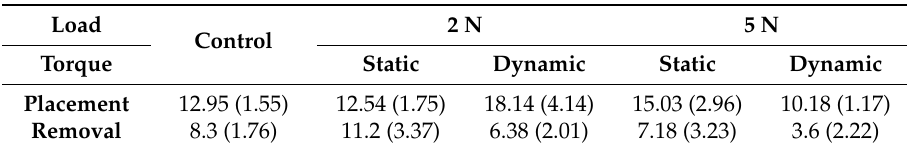
Table 1. Torque peak mean values (Ncm) and standard deviation from screw placement and removal after static and dynamic forces, with loads of 2 N and 5 N.